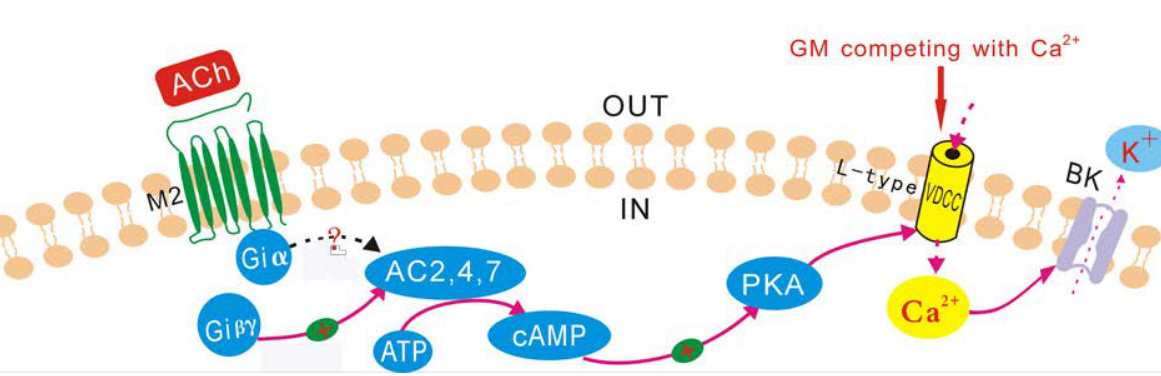
Figure 9. The L -type calcium channel was the probable blocking site of GM . The signal transduction pathway of the ACh-induced BK current in guinea pig VHCs II and the probable blocking site of GM on the pathway. GM probably blocks the ACh-induced BK current mainly by competing with Ca 2+ at the L -type calcium channel. + :